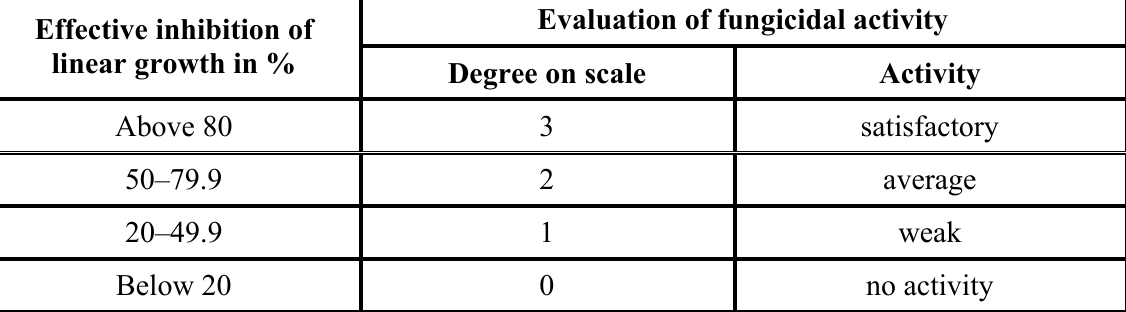
Table 5. Compound’s effectiveness in inhibiting the linear growth of mycelia